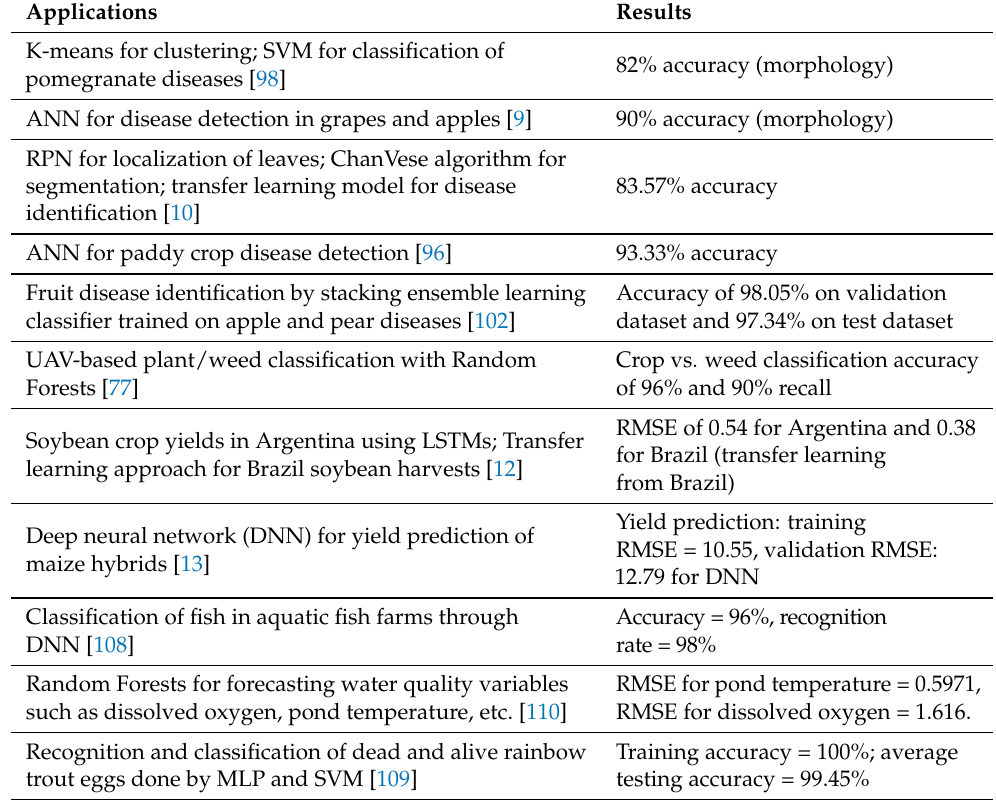
Table 3. Summary of applications of Artificial Intelligence in Smart